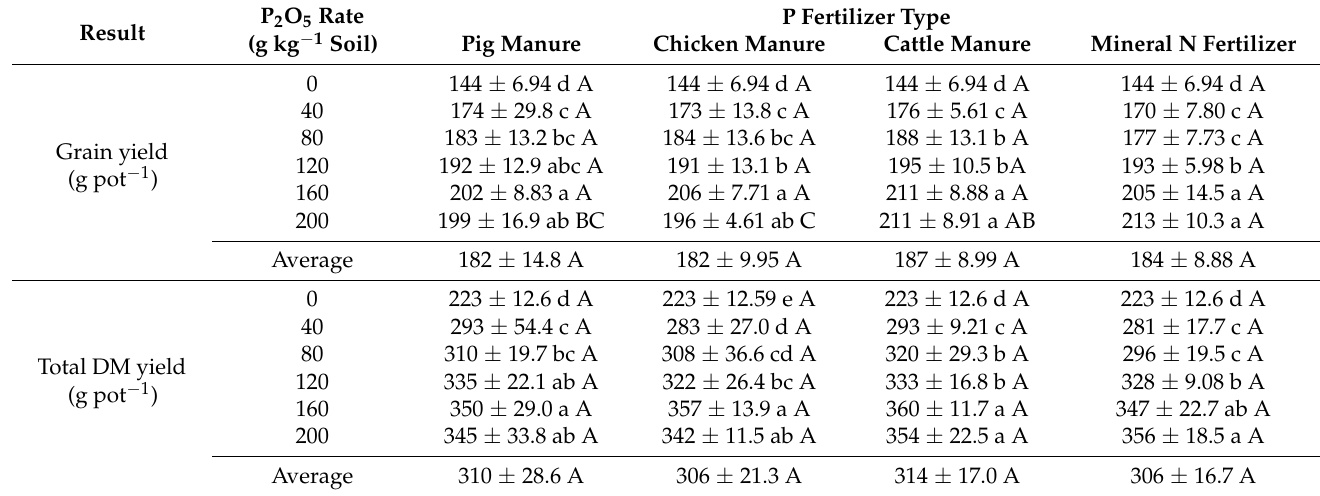
Table 5. Effects of different P fertilizers on summer maize yield and total dry matter.